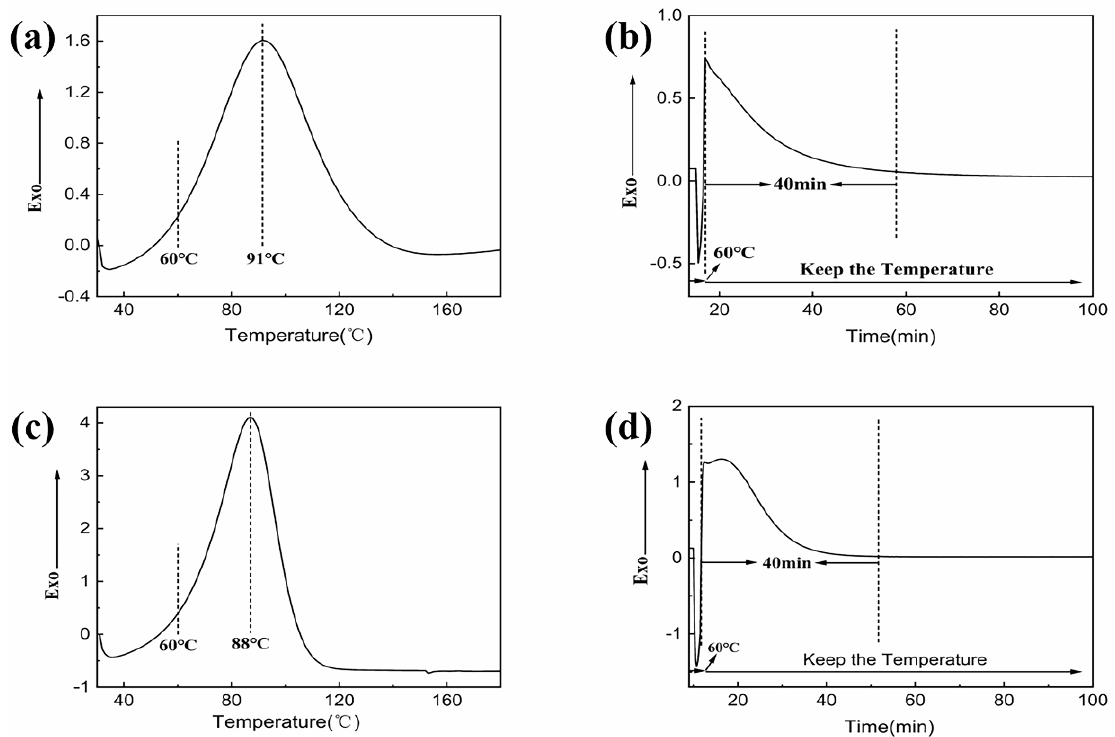
Figure 3. ( a ) The non − isothermal DSC curve of the GT adhesive; ( b ) the isothermal DSC curve of the GT adhesive; ( c ) the non − isothermal DSC curve of the ET adhesive; and ( d ) the isothermal DSC curve of the ET adhesive.